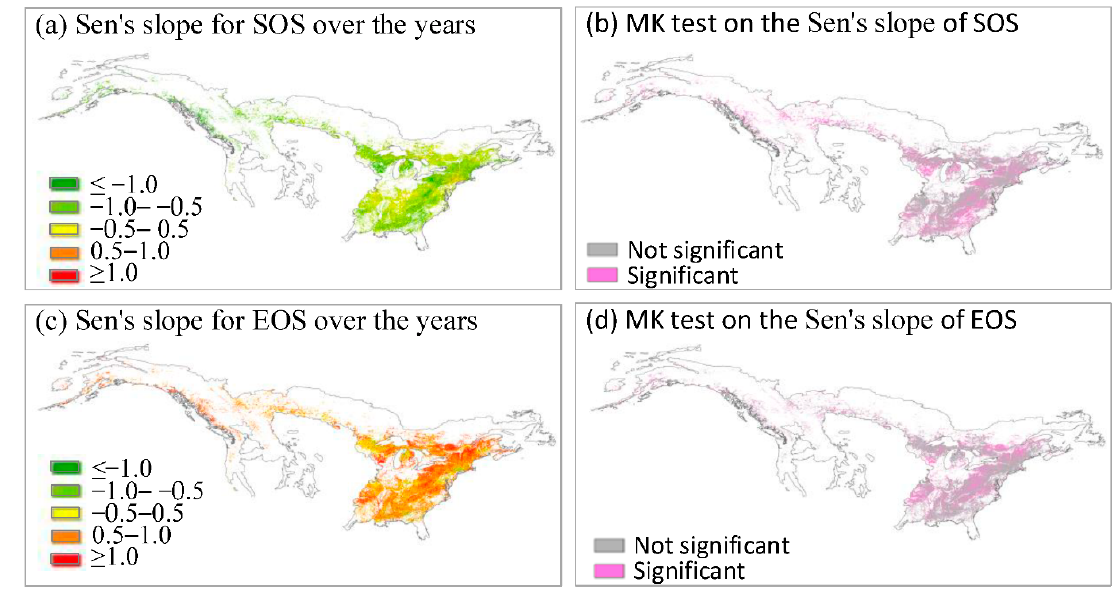
Figure 4. Temporal trajectory of the phenological events (SOS and EOS) in the deciduous forests during 2001–2020.